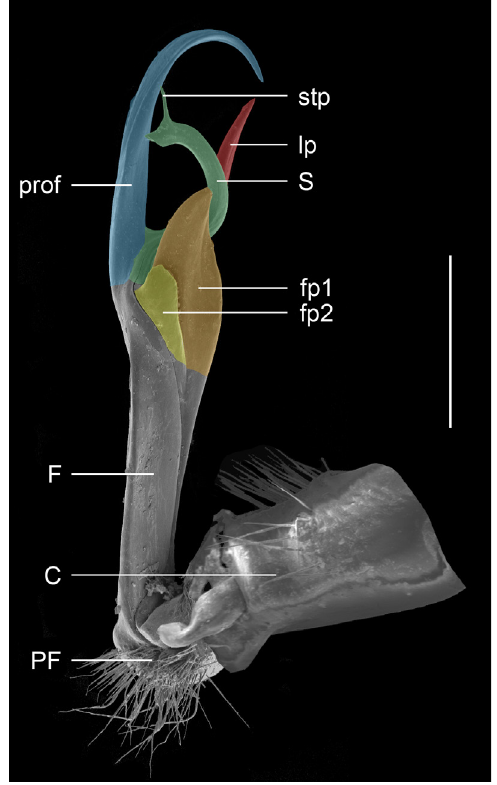
Fig. 1. Right gonopod of Pogonosternum nigrovirgatum (Carl, 1902), mesal view (NMV K-12158). Scale bar: 0.5